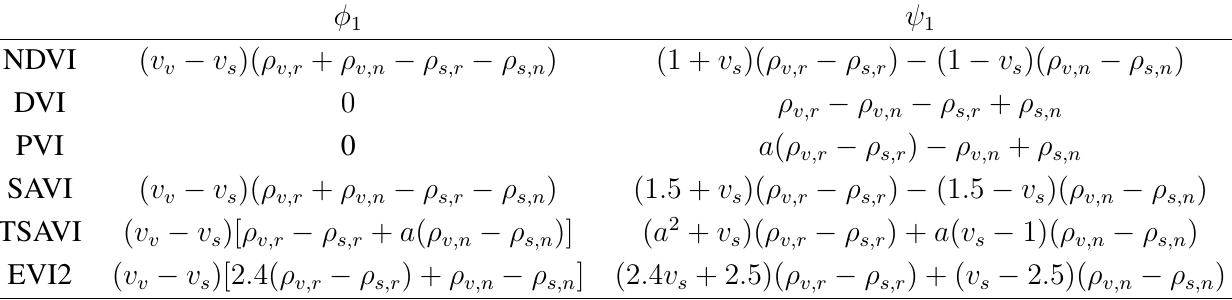
Table 2 . Summary of ϕ and NIR reflectance of vegetation endmember, respectively. Likewise, ρ red and NIR reflectance of non-vegetation endmember, respectively. a represents a slope of soil